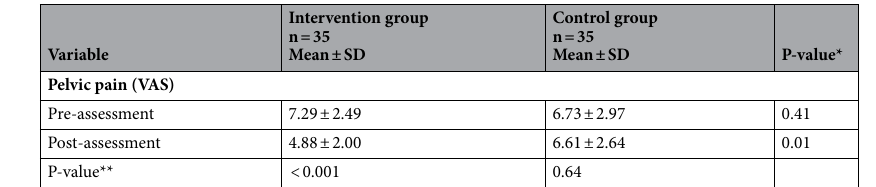
Table 5. Comparison of the Visual Analog Pain Scale between intervention and control groups. *T-test was carried out for comparison of the groups. **Paired T-test was carried out for comparison of changes between the